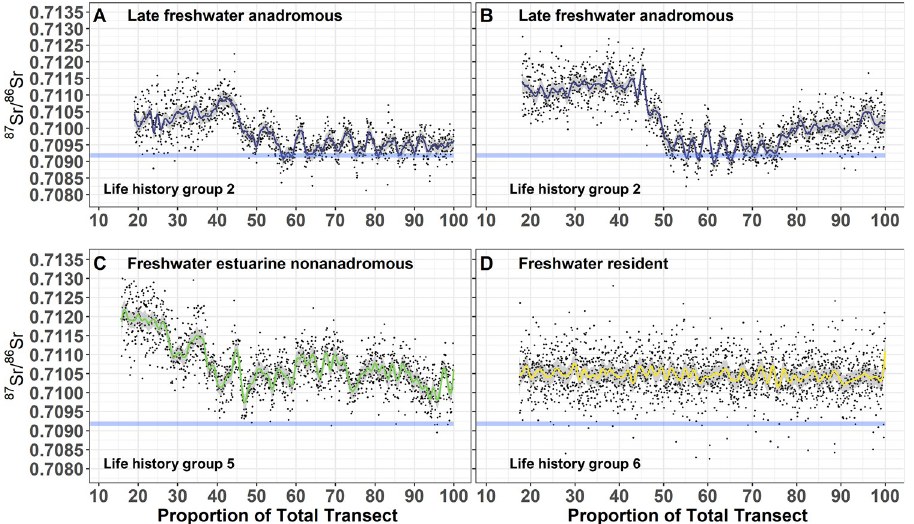
Fig 5. Variation within anadromous and nonanadromous life history types. Variation within anadromous and nonanadromous life history types. Selected otolith 87 Sr/ 86 Sr profiles of four Broad Whitefish ( Coregonus nasus ) from the Colville River, AK, USA, displaying unique variation in anadromous and nonanadromous life history types. Fitted Generalized Additive Model values (solid-colored lines), 95% confidence interval (grey shading), and raw 87 Sr/ 86 Sr for each life history type (black dots) from the otolith core to edge are shown. Freshwater late anadromous life history type displaying continued marine habitat use (A), freshwater late anadromous life history type displaying a switch to freshwater habitat later in life (B), freshwater estuarine nonanadromous life history type demonstrating delayed estuarine habitat use (C), and freshwater resident life history type demonstrating relatively stable 87 Sr/ 86 Sr across time (D). The horizontal light blue line represents the global mean oceanic value (GMV = 0.70918 ± 0.00006 2 SD).